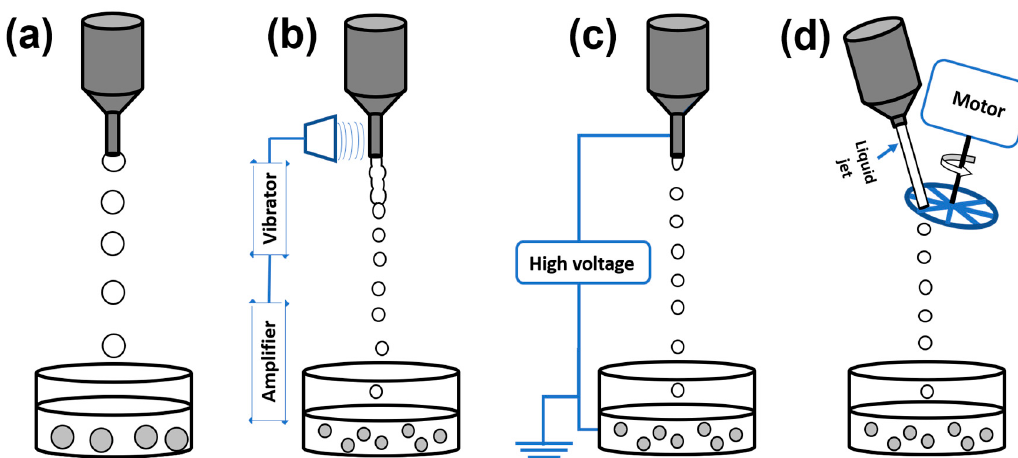
Figure 2. Illustration of dropping devices: ( a ) conventional dropping method influenced by gravity, surface tension and viscosity; breaking up of liquid jets into droplets stimulated by ( b ) vibrating nozzle method, ( c ) electrostatic forces and ( d ) a mechanical cutting device.